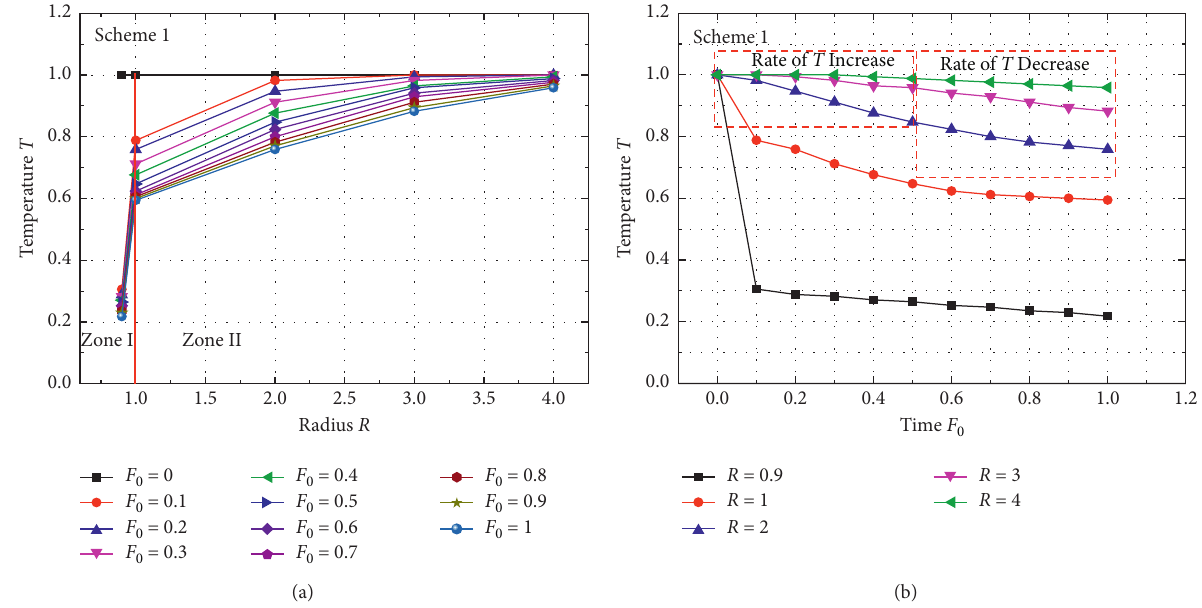
Figure 6: T − R curve and T − F